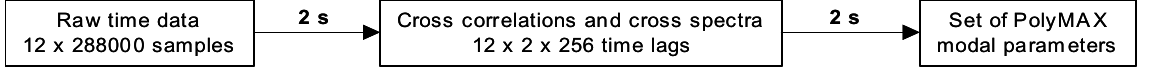
Raw time data 12 x 288000 samples Fig. 6. Reduction of 4 hours of time data to a set of modal parameters using the PolyMAX method requires 4 seconds of computation